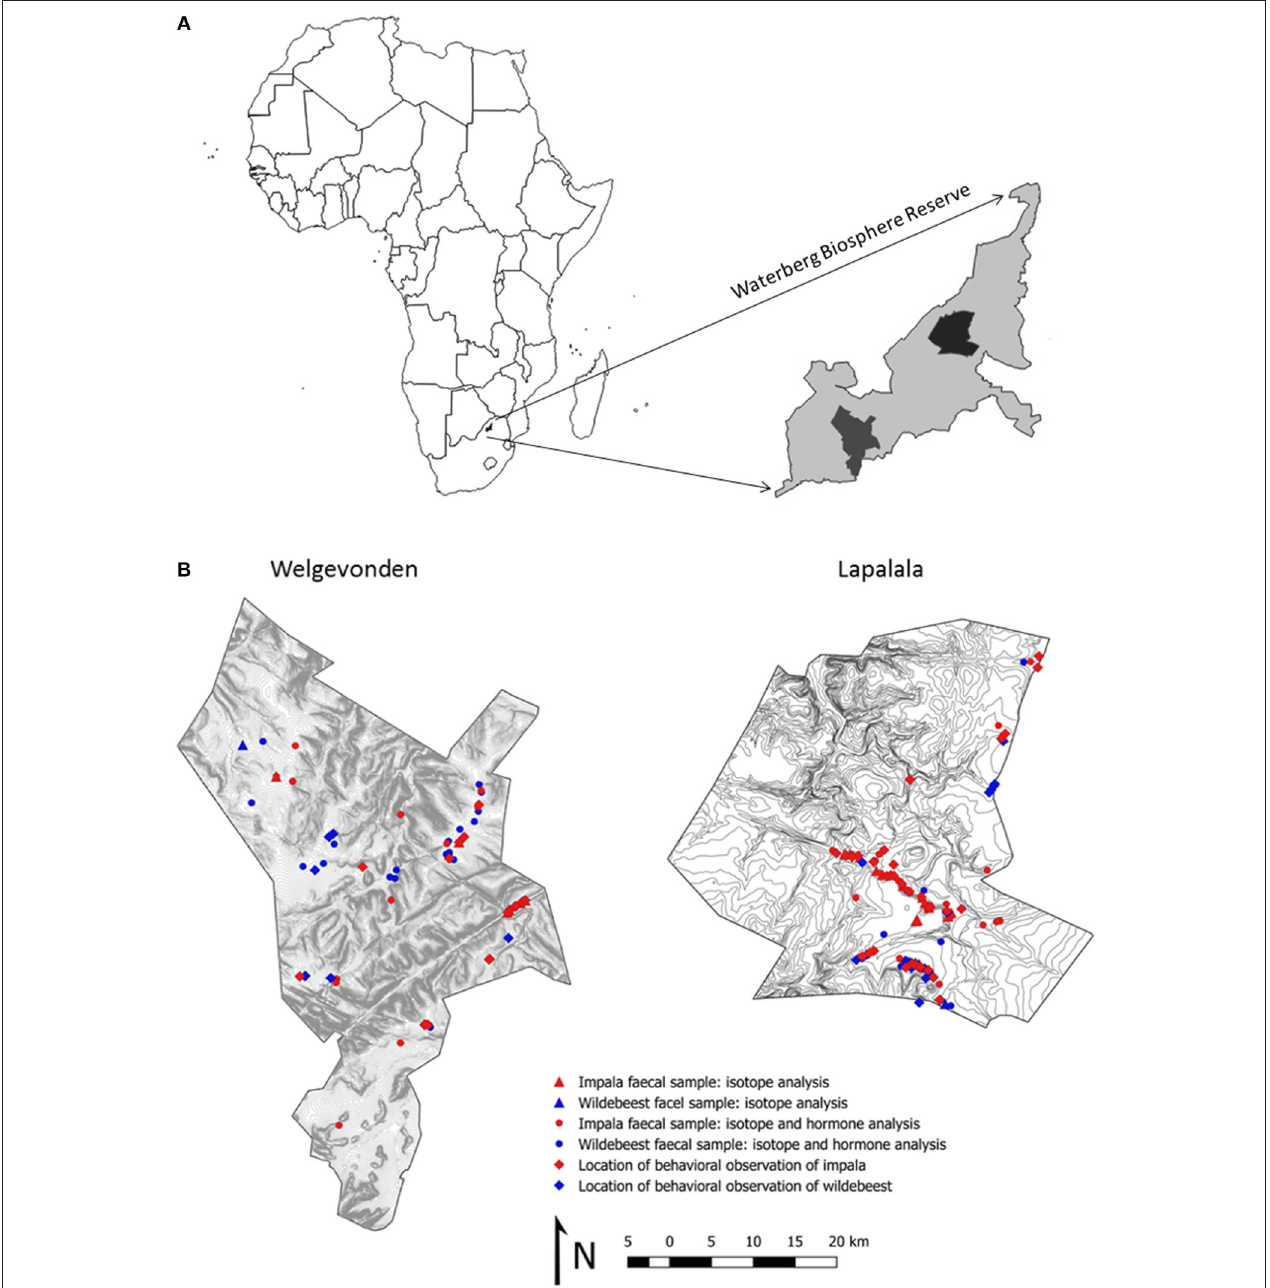
FIGURE 1 | Location of the two study sites within the Waterberg Biosphere Reserve (A) as well as detailed maps of each reserve including locations for behavioral observations and collected fecal samples (B) .